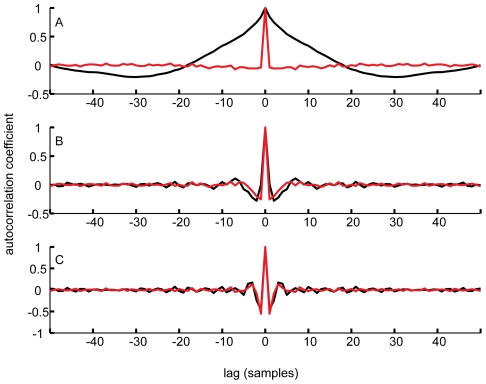
Autocorrelation functions during filtering.Plots of the normalized autocorrelation functions of the residuals of the 500 fps x-position data (black lines) after filtering at: (A) 10 Hz, (B) 48 Hz and (C) 100 Hz. For comparison, we also plot the normalized autocorrelation function of the residuals of a sequence of Gaussian white noise of the same length passed through each of the filters (red lines). For this method we selected a cut-off frequency at which the lowest frequency at which the autocorrelation function of the residuals of the actual data still matched closely the autocorrelation function of the residuals of the random sequence - in this case, at around 48 Hz. An animation of the change with respect to cut-off frequency of the autocorrelation (and the variance of the autocorrelation) can be found in Supporting Information.